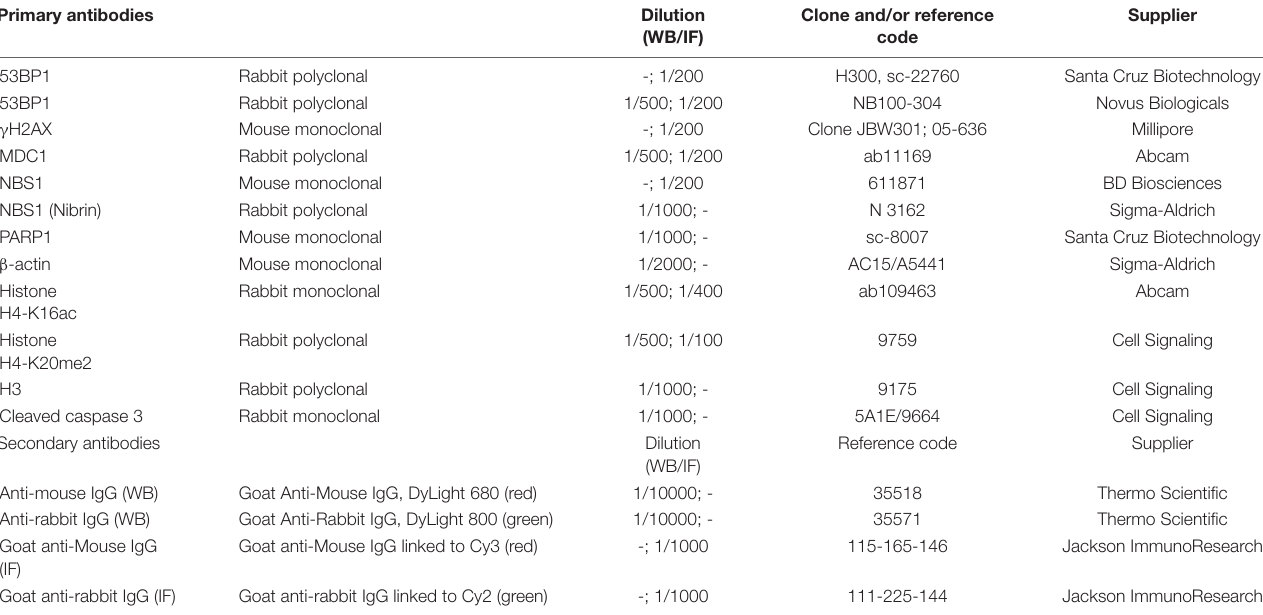
TABLE 1 | List of antibodies and